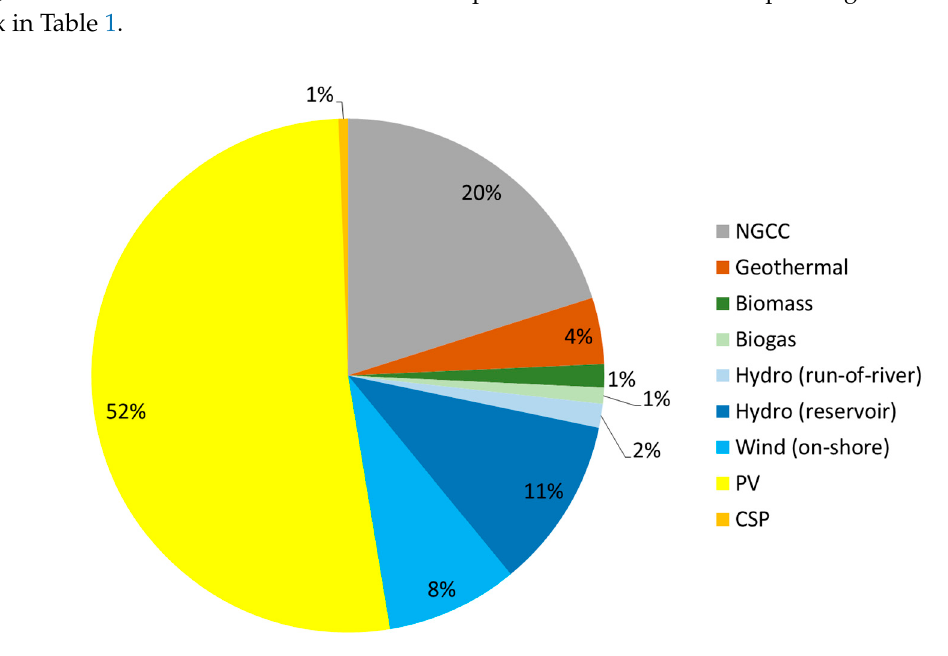
Figure 6. California domestic electricity generation mix—projected data for 2030. Total domestic generation is expected to be 199 TWh. NGCC = natural gas combined cycles; PV = photovoltaics; CSP = concentrating solar power.